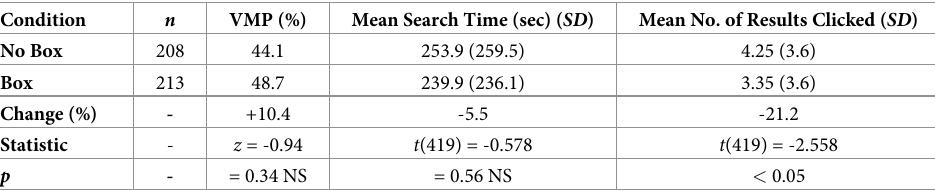
Table 1. Experiment 1: VMP, search times, and results clicked by